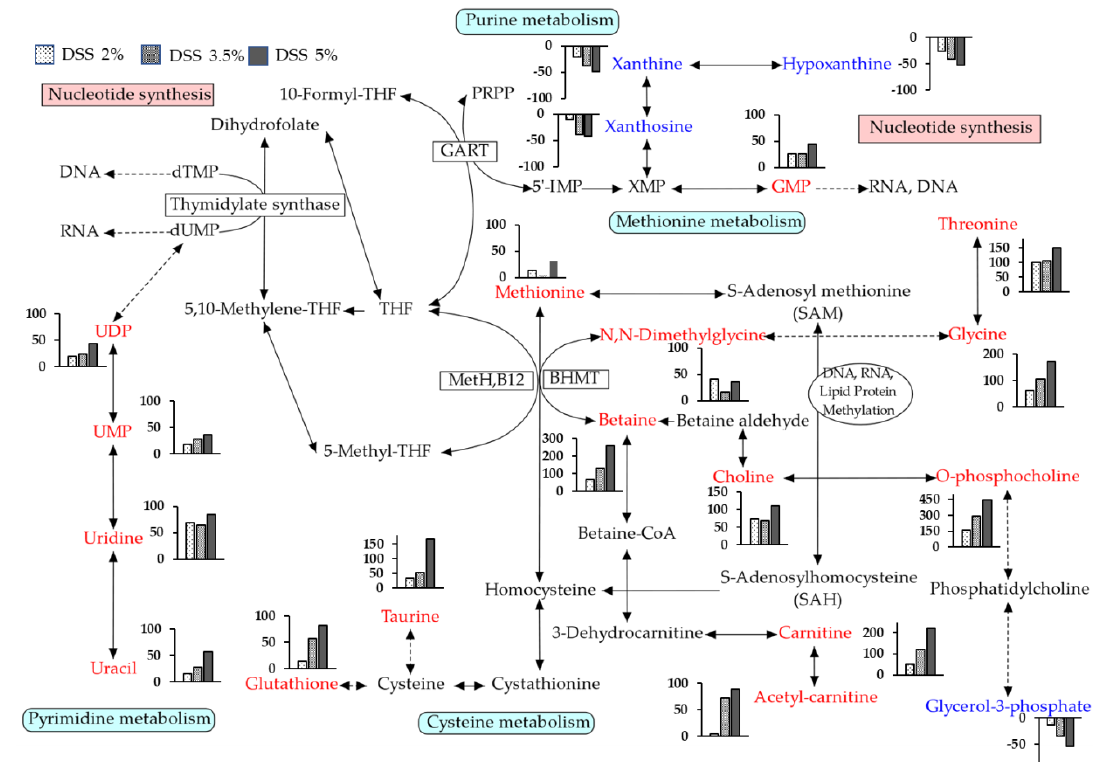
Figure 11. Summary of one-carbon metabolism, purine metabolism, pyrimidine metabolism, and transsulfuration pathways in the liver with UC.